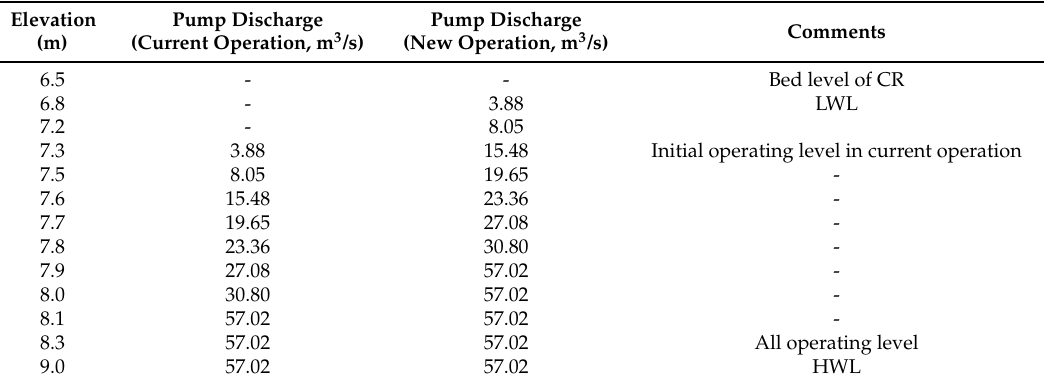
Table 4. Current and new operation of drainage pumps in the centralized reservoir (CR). Elevation Pump Discharge (m) (Current Operation, m 3